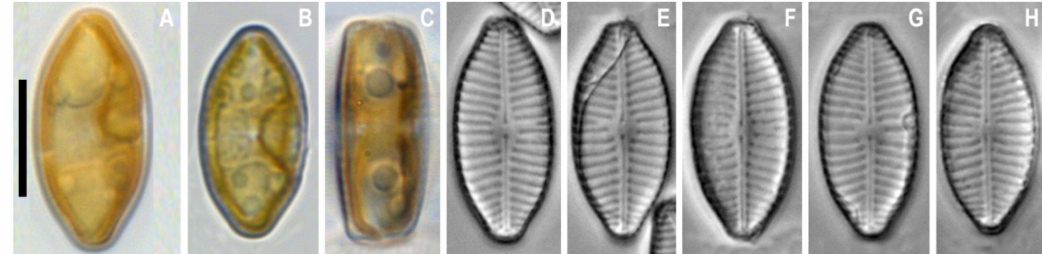
Figure 8. Placoneis neohambergii Kezlya, Glushchenko, Kulikovskiy & Kociolek sp. nov. Strain VN364, slide no. 00134. ( A – H ) Light microscopy, differential interference contrast, size diminution series. ( A – C ) Live cells with chloroplast structure. ( D ) Holotype. Scale bar = 10 µ